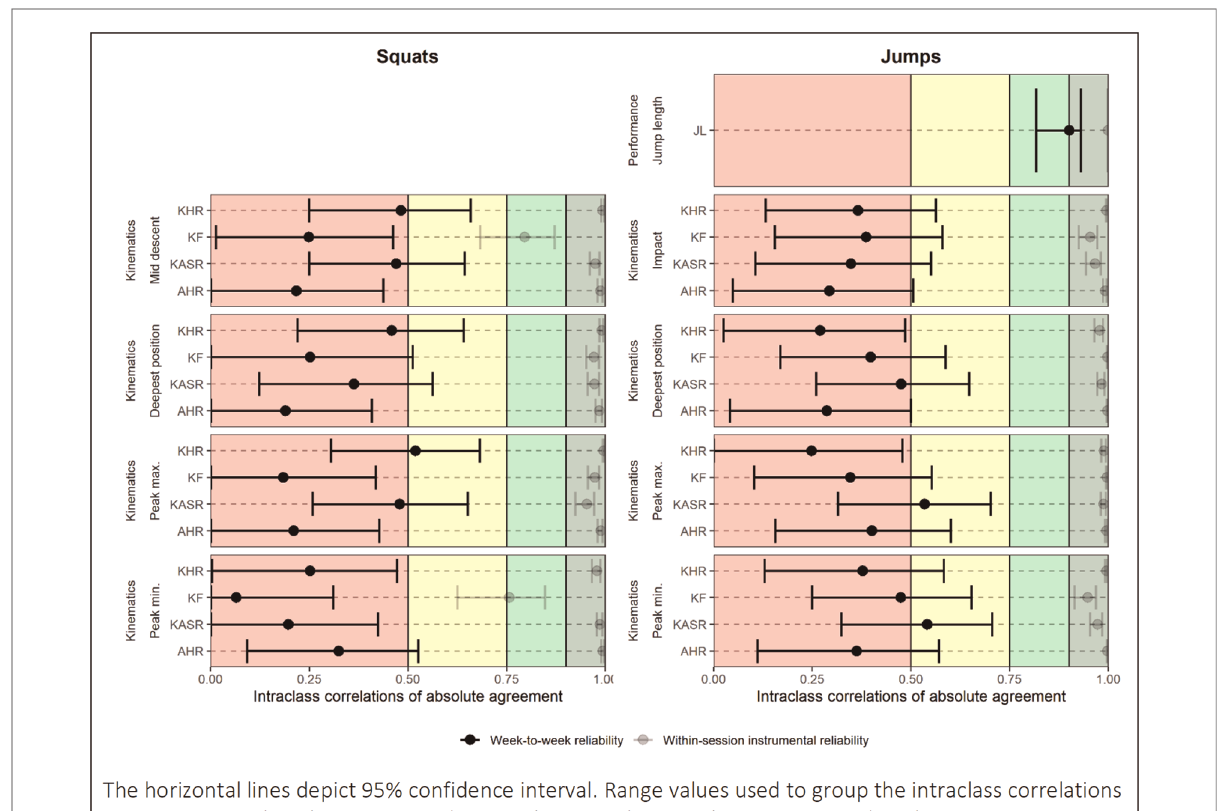
FIGURE 4 Week-to-week test-retest reliability of performance and kinematic variables captured in 63 preschool children performing squats and jumps. The horizontal lines depict 95% con fi dence interval. Range values used to group the intraclass correlations as either “ poor ” (<0.5), “ moderate ” (0.5 – 0.75), “ good ” (0.75 – 0.9), or “ excellent ” (>0.9) are marked by the background colors (red, yellow, light-green, and dark-green). SqD, squat depth; JL, jump length; KHR, knee-to-hip separation ratio; KF, knee- fl exion; KASR, knee-to-ankle separation ratio; AHR, ankle-to-hip separation